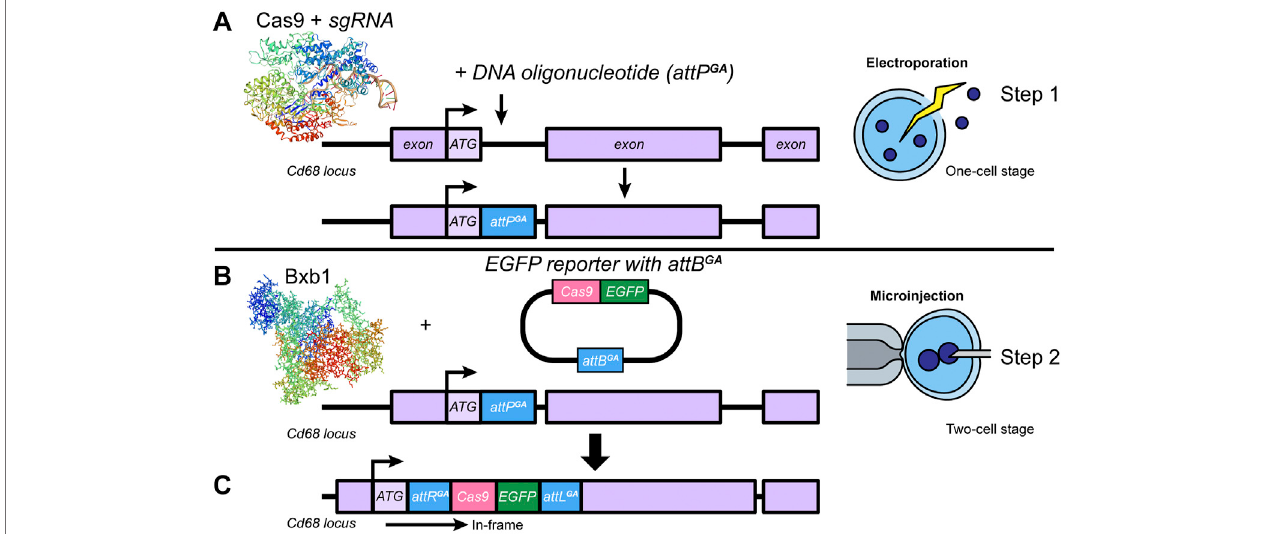
FIGURE 2 | Bxb1-mediated targeted transgenesis of mouse zygotes in one-step. (A) At the zygote one-cell stage, using Cas9-mediated HDR, we inserted an attP GA site in the Cd68 locus, adjacent to the start codon (ATG). (B) At the two-cell stage, in the same embryos, using Bxb1 we inserted a Cas9-EGFP reporter gene containing a cognate attB GA site. (C) The alleles with correct integration were used for germline